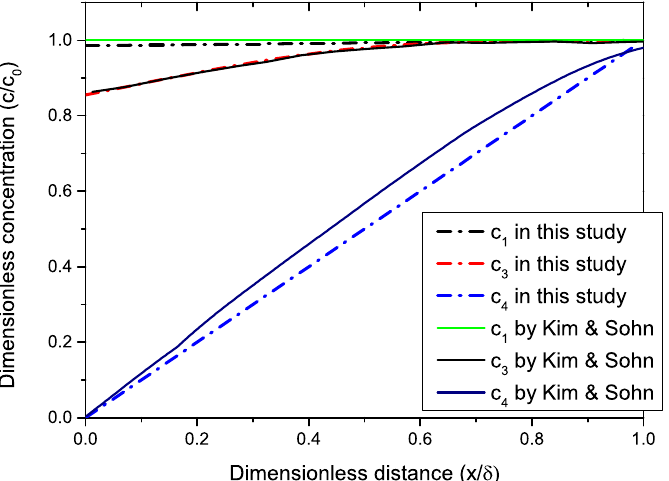
Figure 7. Concentration profiles of three chemical species versus x computed by the one-dimensional system (65) and compared with the results of the full two-dimensional